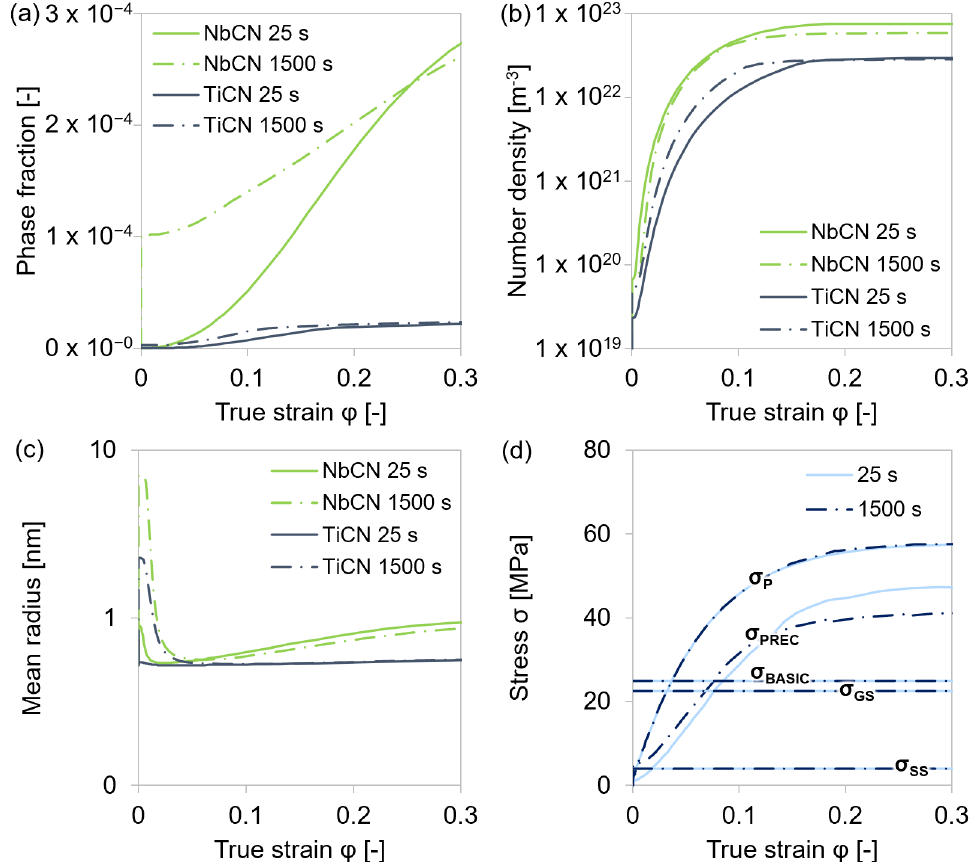
Figure 14. Analysis of precipitates and stresses during simulation of a single-hit compression test of steel grade S4 at 1153 K with varied holding time before deformation and 0.01 s − 1 strain rate. ( a ) Phase fraction of precipitates. ( b ) Number density of precipitates. ( c ) Mean radius of precipitates. ( d ) Stress contributions without thermal activation of simulated stress–strain curves with ABC parameters calculated from Equations (7)–(9).